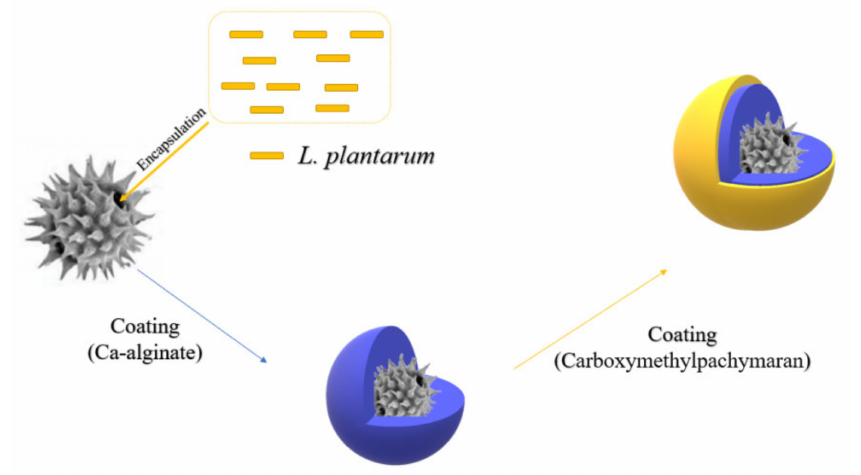
Figure 6. Schematic diagram of a new core-shell